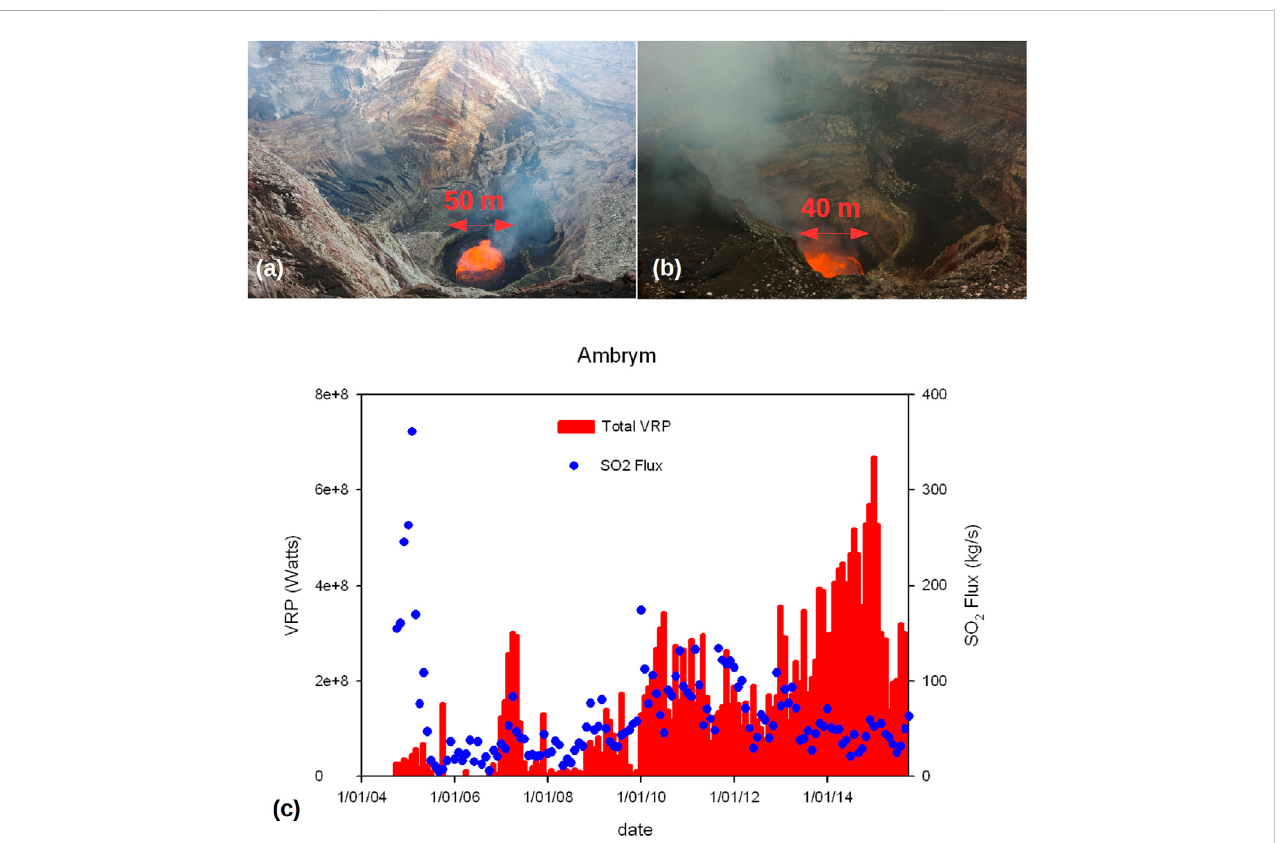
FIGURE 6 LavalakesofBembow (A) andMarum (B) inDecember2014.Atthistime,theirareaswereapproximately identical,butbothhavesufferedlargevariations of their size and level (photos: C. Normand). (C) Time series of the monthly averaged SO 2 fl ux and monthly maximal Volcanic Radiative Power from the lava lakes of Ambrym Volcano. The generally increasing trend of the VRP that culminated with the partial lake draining event of 2015 was decoupled or even anticorrelated with the SO 2